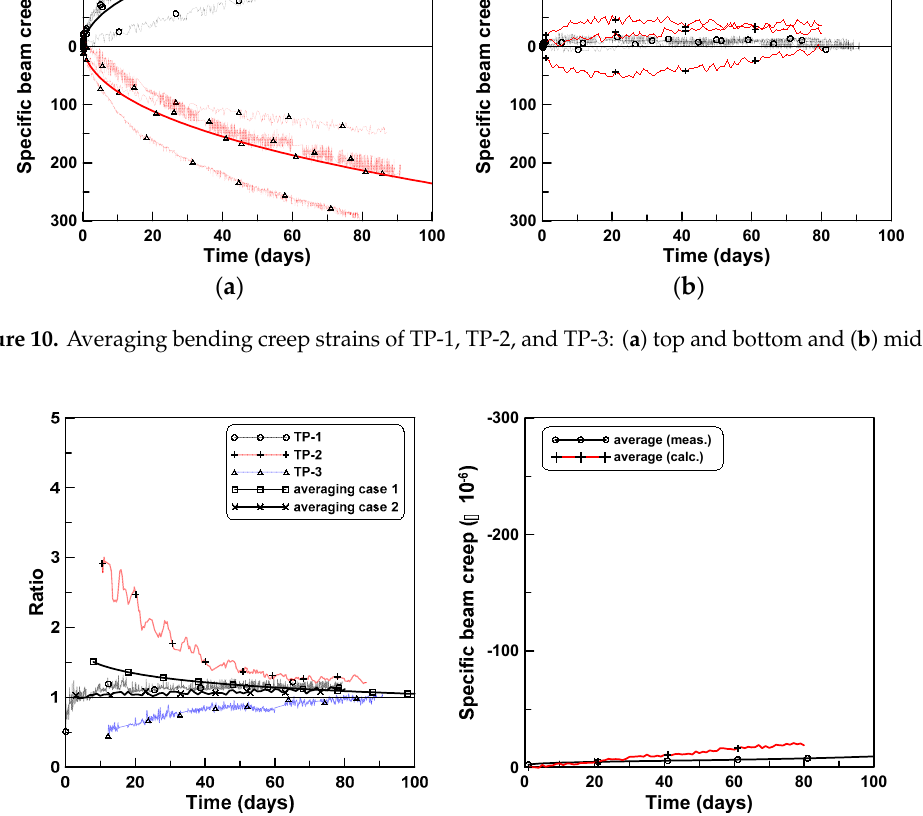
Figure 10. Averaging bending creep strains of TP-1, TP-2, and TP-3: ( a ) top and bottom and ( b ) middle.